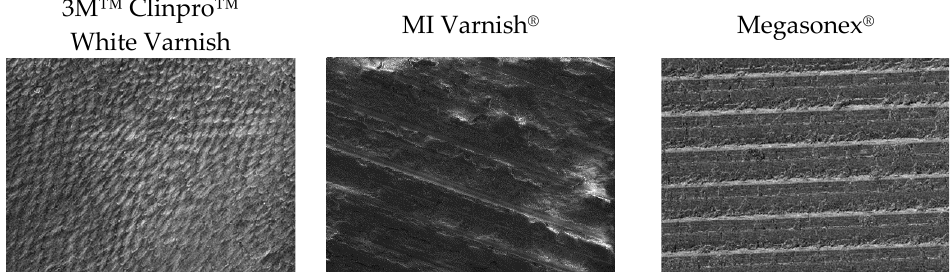
Figure 1. Representative SEM images (accelerating voltage of 5 kV, working distance of 10 mm, magnification of 500×) of the sample surfaces before remineralization.